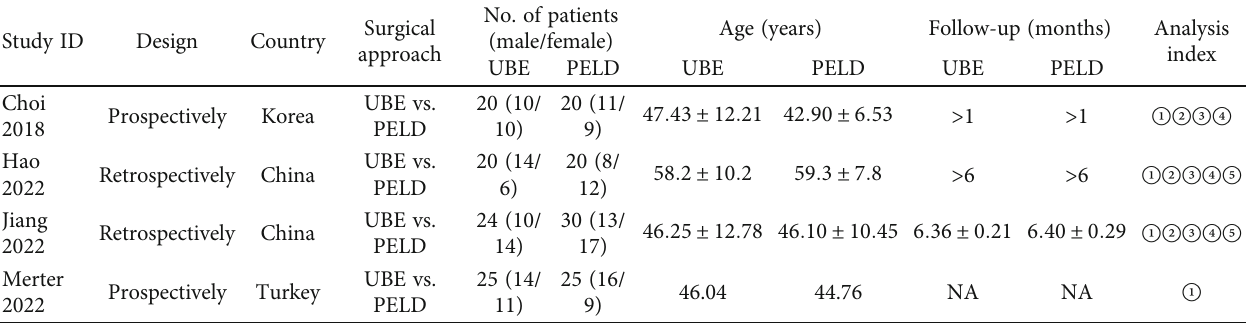
Table 1: Baseline characteristics of the studies included in the meta-analysis.